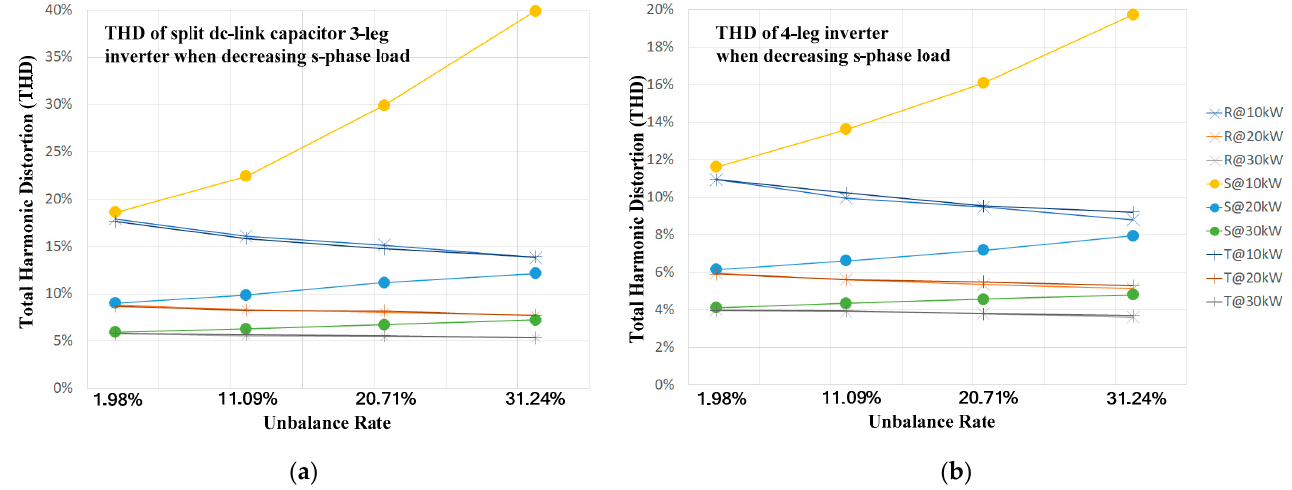
Figure 7. Comparison of the THD of the inverter output current when the inverter compensates for load imbalance due to the reduction of the s-phase load, with a constant output: ( a ) split dc-link capacitor 3-leg inverter; ( b ) 4-leg inverter.